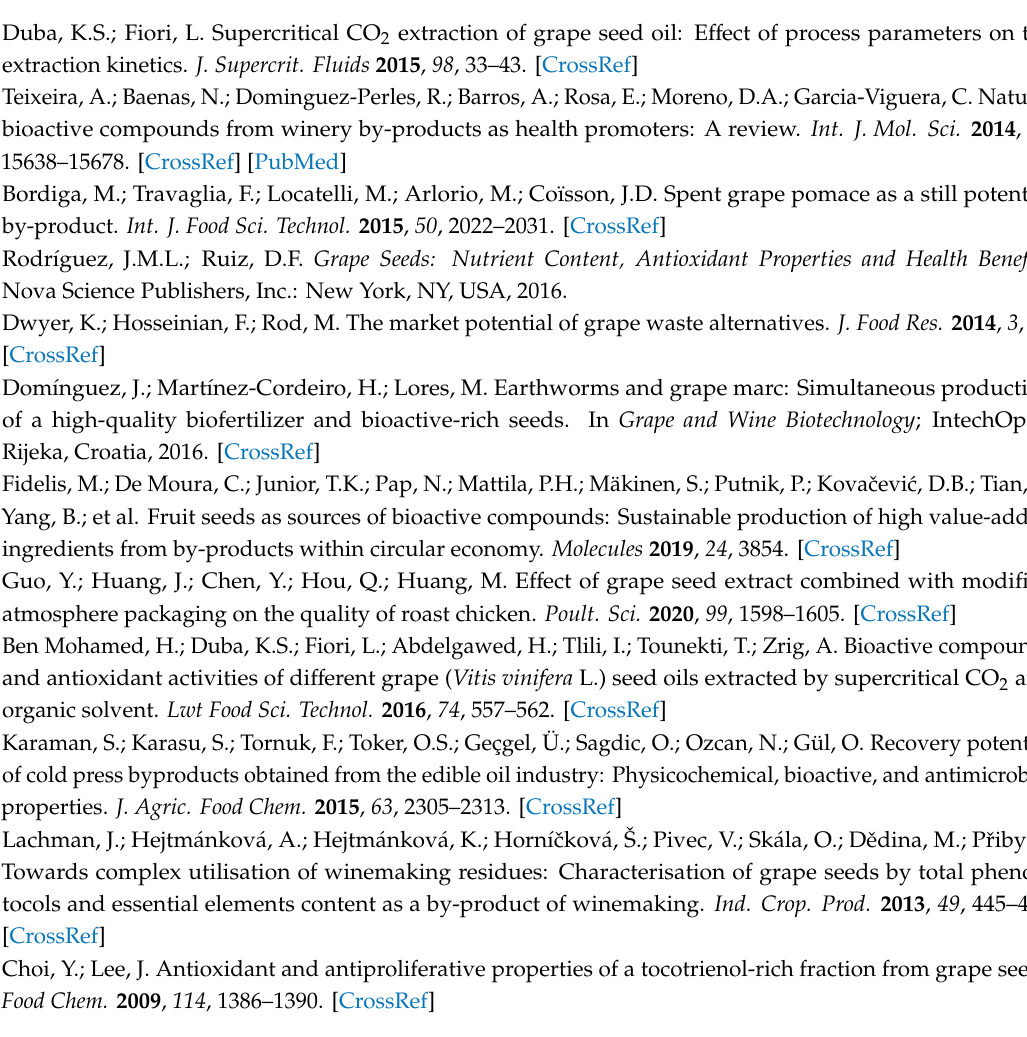
Table S1: Influence of di ff erent extraction parameters on tocopherol yield in red grape seed oil samples (mg 100 g − 1 ); Table S2: Influence of di ff erent extraction techniques on tocopherol yield in grape seed oil (mg 100 g − 1 ); Table S3: Relative content of fatty acids (%) in all obtained